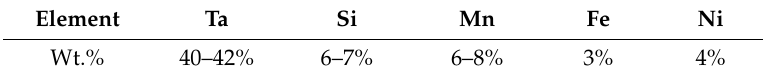
Table 2. Concentration of elements in the